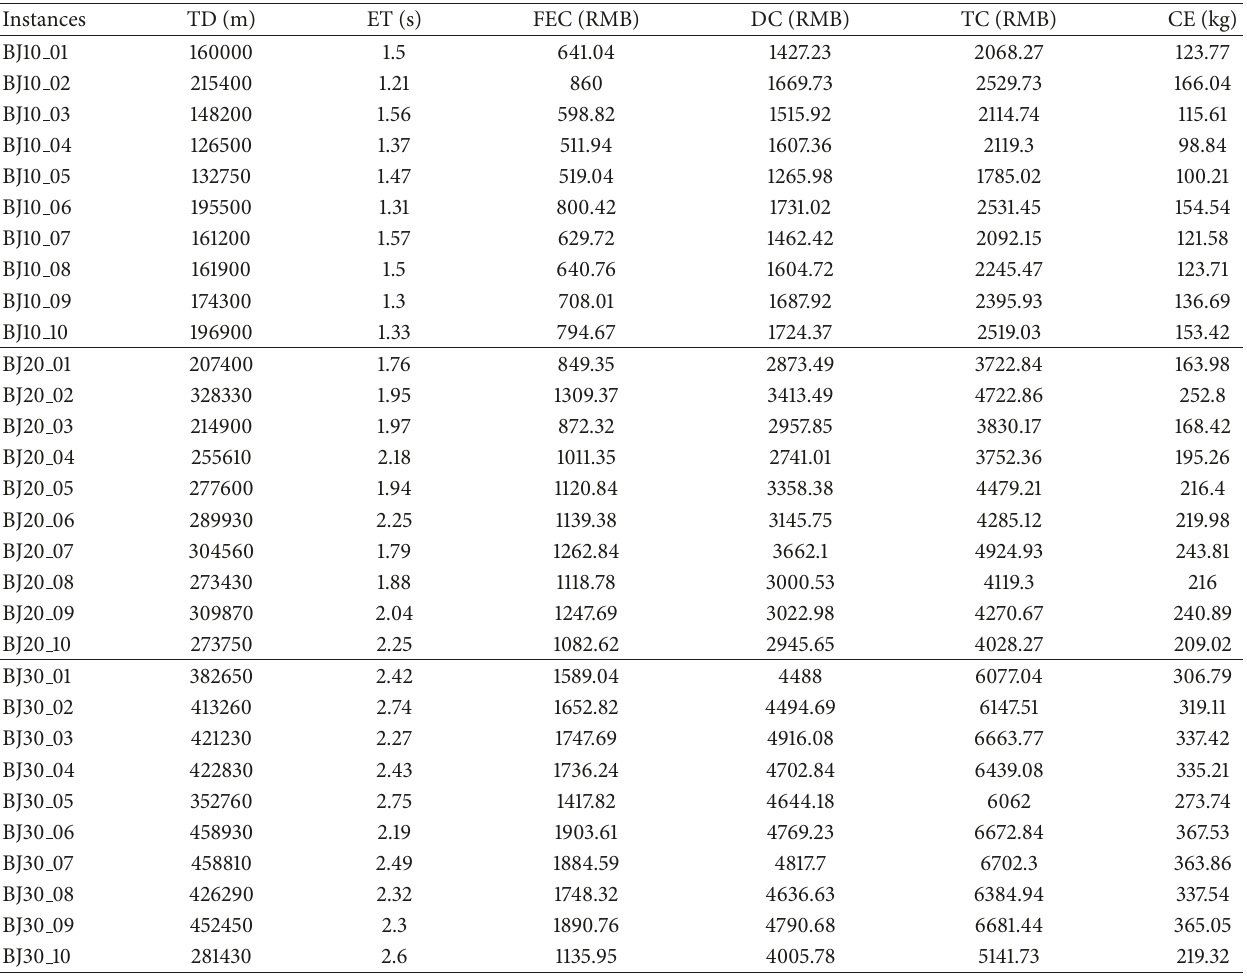
Table 5: Cost components with Min FEC.